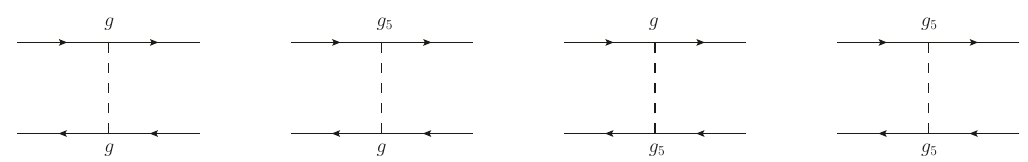
Figure 1 . Leading order NRY γ diagrams for the potential matching with scalar and pseudo-scalar 5 interactions required to calculate V ( p , r , σ 1 , σ 2 )